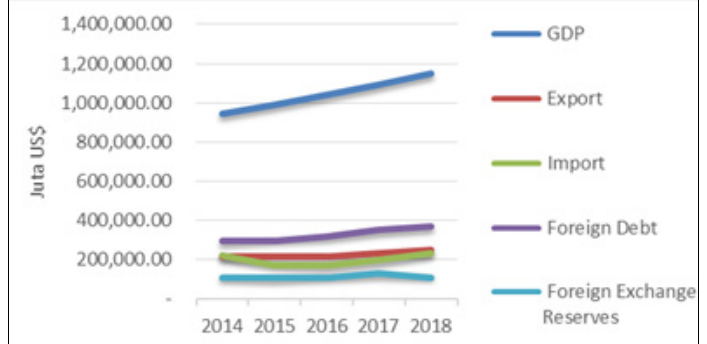
Figure 1: Trend of GDP and International